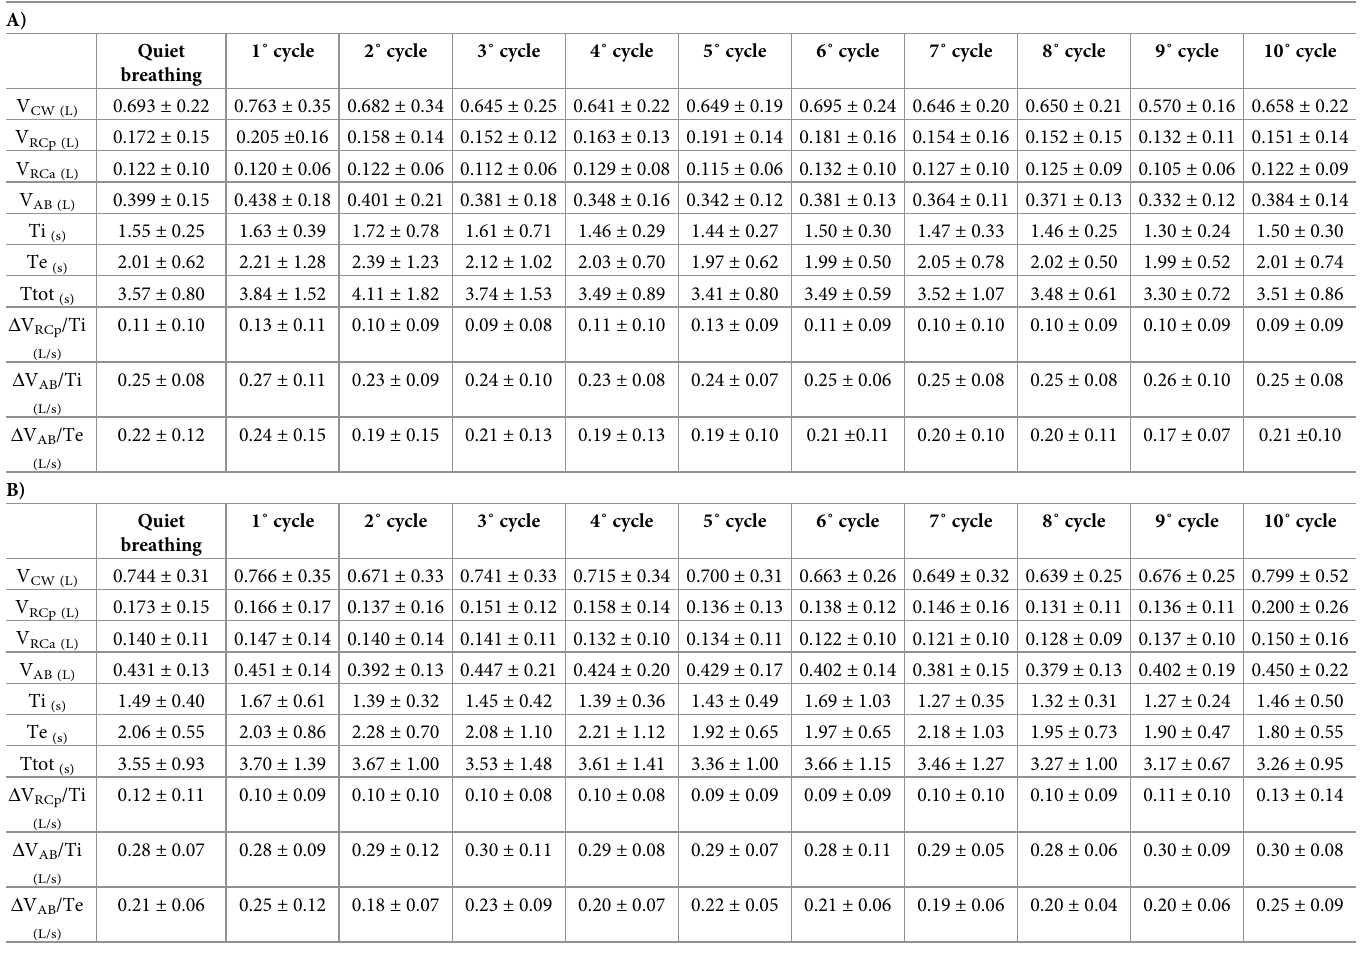
Table 2. Effects of deep inspiration (A) and inspiratory contraction (B) from total lung capacity on chest wall volumes. A) Quiet breathing